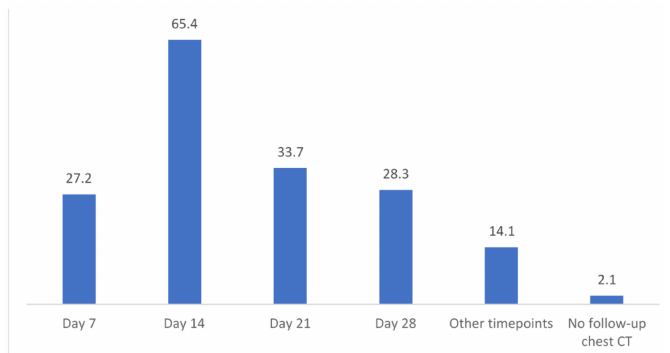
Figure 4. Timepoints and percentages of follow-up CT if IPA was diagnosed in a patient, n = 92 valid responses. CT = computed tomography; IPA = invasive pulmonary